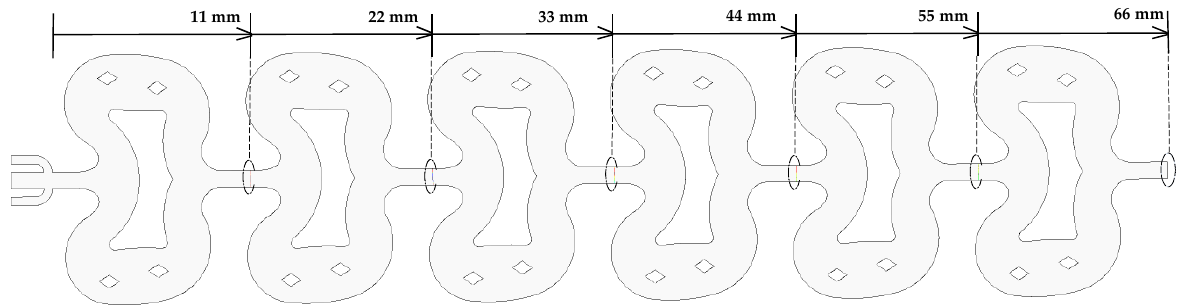
Figure 5. Schematic diagram of the position of each section.